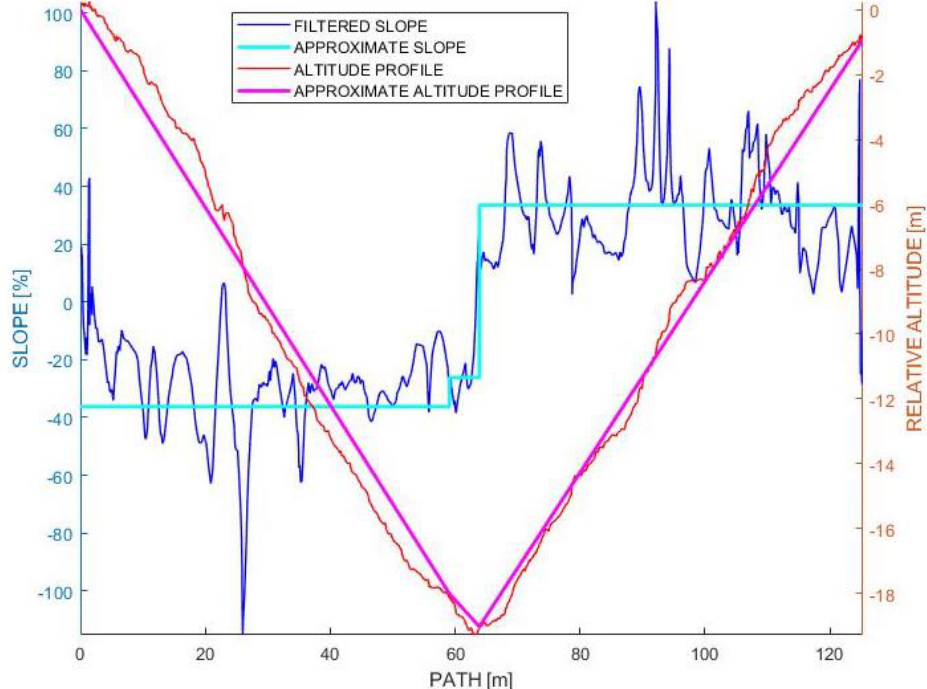
Figure 16. Elevation profile with average profile for downhill, row change and uphill navigation, in red and magenta, right scale. Current slope and average slope for navigation downhill, between rows and uphill, in blue and cyan, left